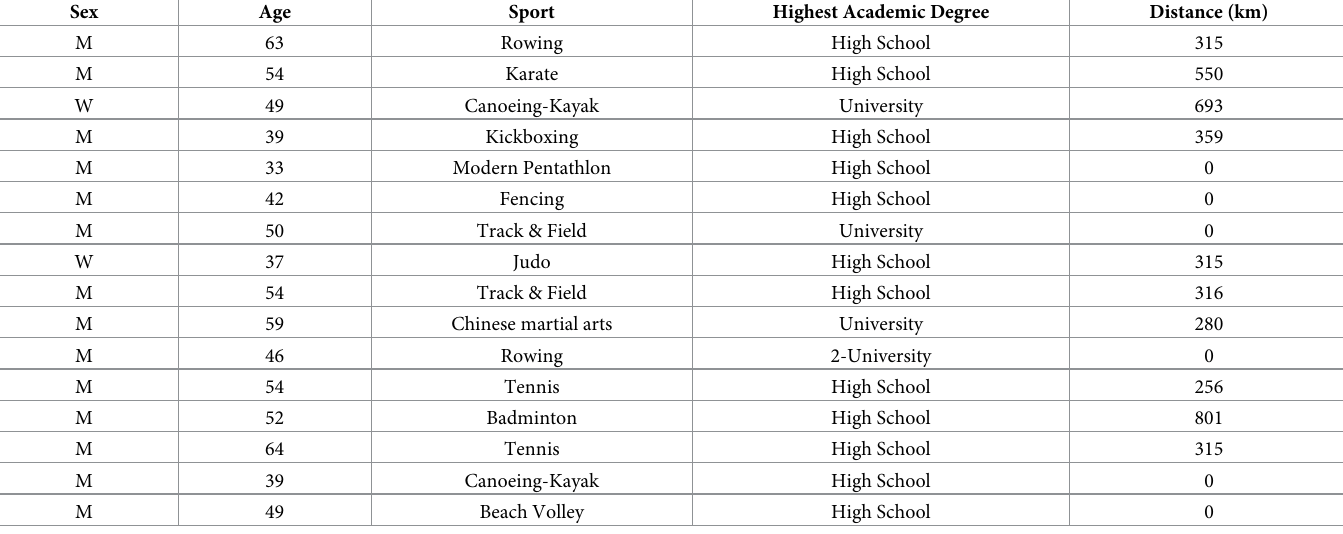
Table 1. Characteristics of the participants, their educational level, and distance between hometown and the university town. Sex